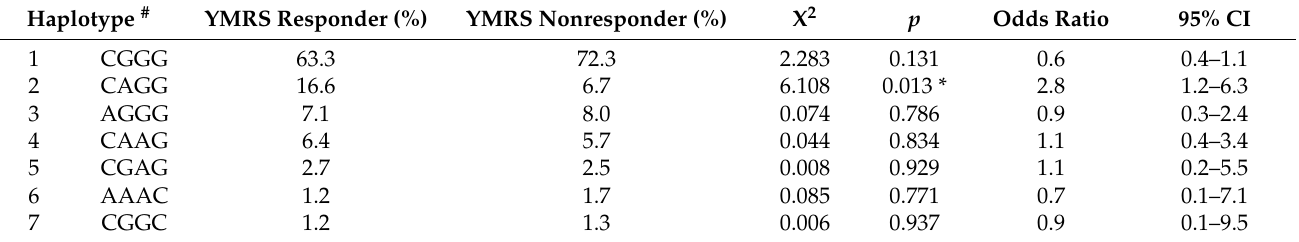
Table 5. Haplotype frequencies of the 4 polymorphisms in the LEPR gene in YMRS responders and